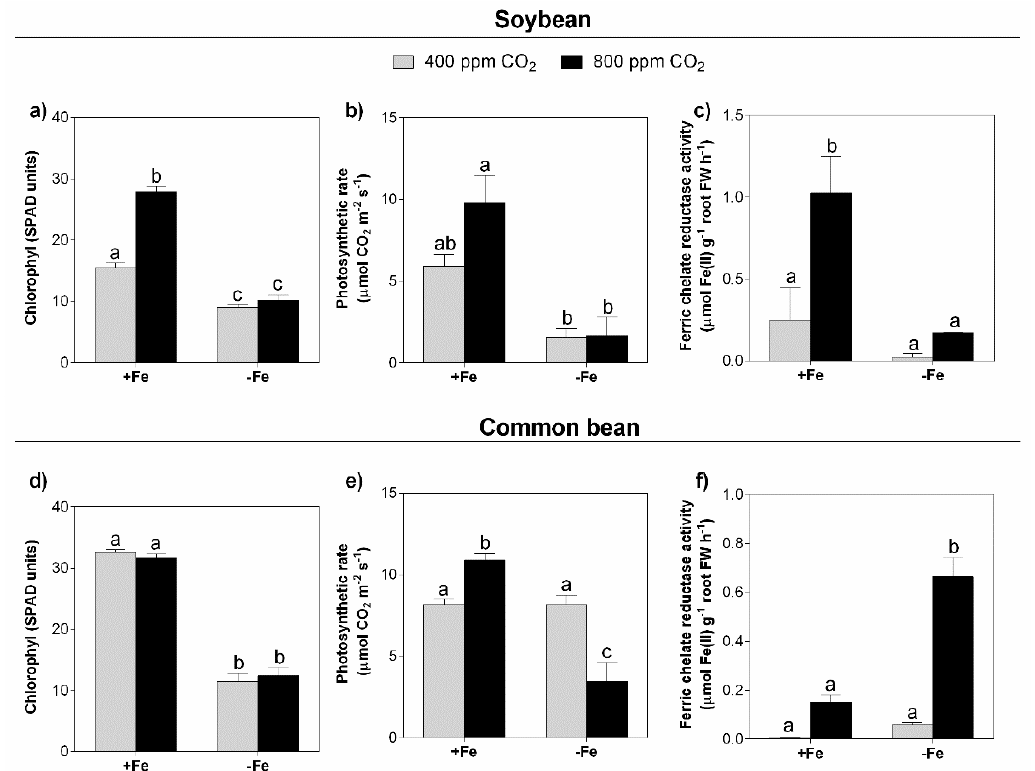
Figure 2. SPAD values ( a , d ), photosynthetic rate ( b , e ) and ferric chelate reductase activity ( c , f ), of soybean and common bean plants grown at 400 ppm and 800 ppm CO 2 and with 0 ( − Fe) and 20 µ M Fe-EDDHA (+Fe). The results represent the mean of five biological replicates ± SE. Different letters above bars indicate significant differences p < 0.05 using the Tukey test.